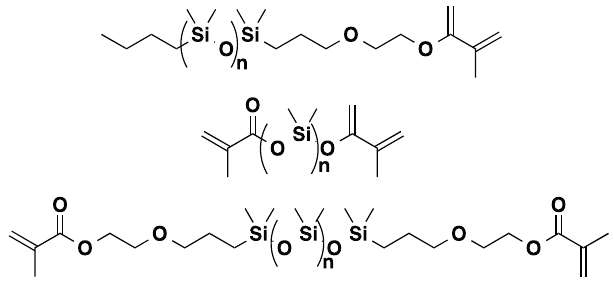
Figure 7. CALB catalyzed methacrylation of